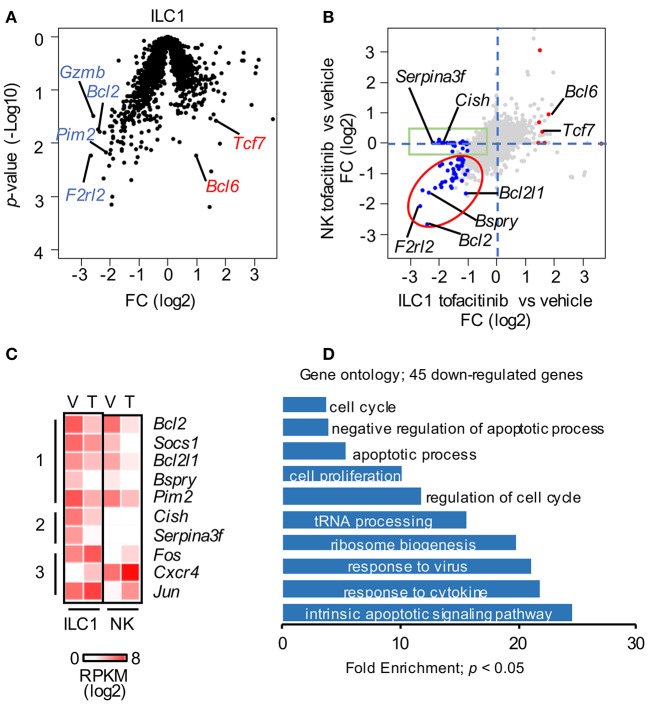
Redundant effect of tofacitinib on ILC1 and NK cell transcriptomes. (A) Volcano plot for genes expressed by liver ILC1 isolated from mice treated or not for 1 week with tofacitinib. Representative down-regulated (blue) and up-regulated (red) genes are highlighted. (B) Scatter plot comparing the effects of tofacitinib on NK and ILC1. Genes significantly (p < 0.05) up-regulated (FC > 2) and down-regulated (FC < 0.5) in ILC1 are highlighted in red and blue, respectively. (C) Expression of selected genes in liver and splenic NK cells is depicted by heatmap, comparing mice administered with vehicle or tofacitinib. (D) Forty-five down-regulated genes in ILC1 having RPKM > 5; FC < 0.5; p-value < 0.05 were selected for GO. Only GO terms with a p-value < 0.05 are represented. More than 10 mice for each group (vehicle and tofacitinib) were pooled.